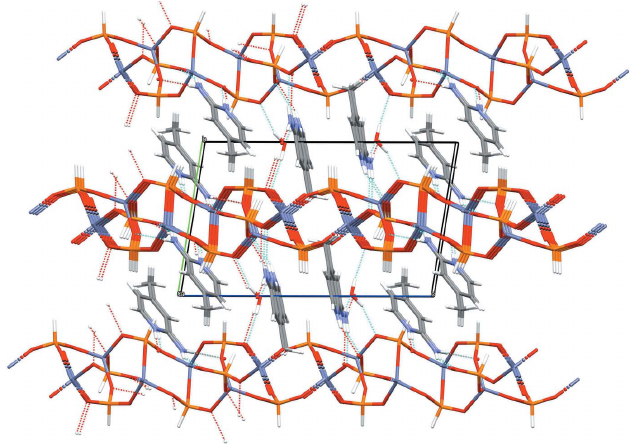
Figure 11 The unit-cell packing in (IV) viewed down [100]. Hydrogen bonds are shown as dashed lines.